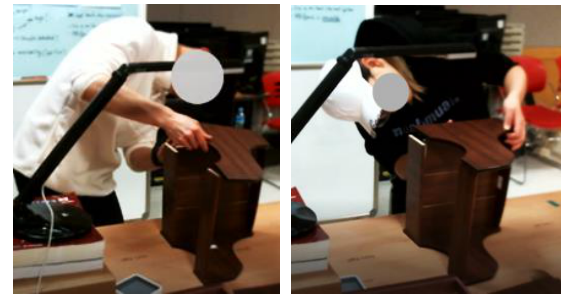
Figure 16. Installation of the side panel to the main panel.